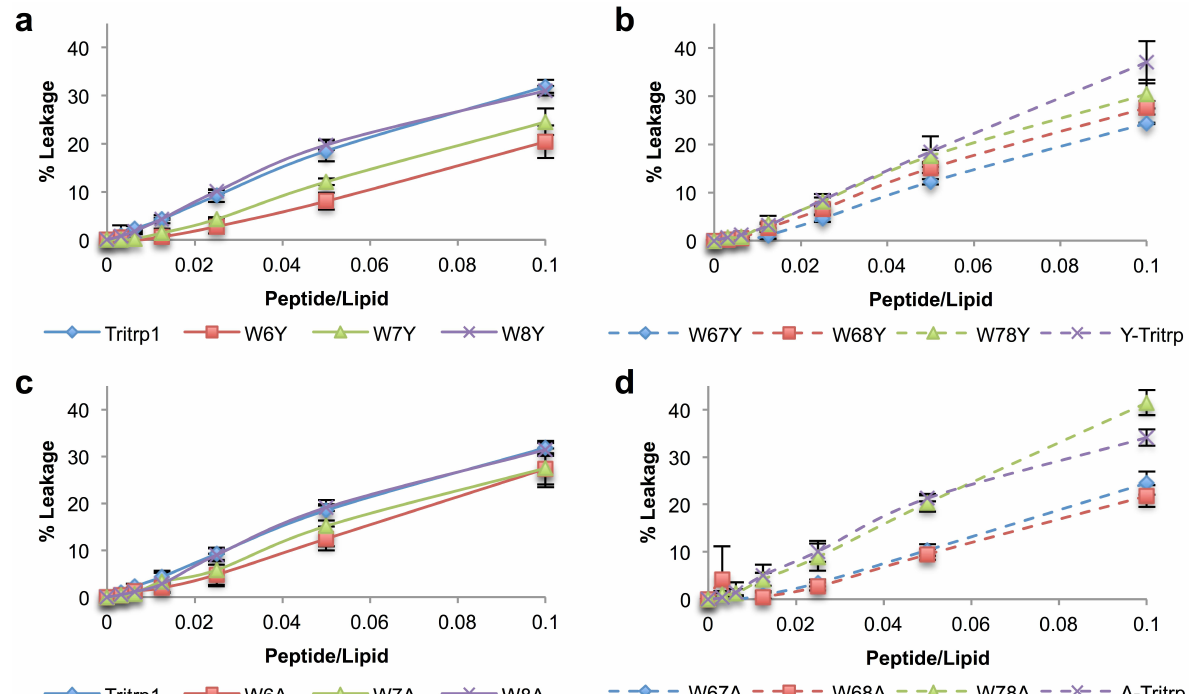
Figure 4. Calcein leakage for Tritrp1 and its analogs in the presence of ePC:ePG (1:1) vesicles. Single-substituted peptides with Tyr ( a ) and Ala ( c ). Double-substituted peptides with Tyr ( b ) and Ala ( d ). Results are the mean ± SD ( n =